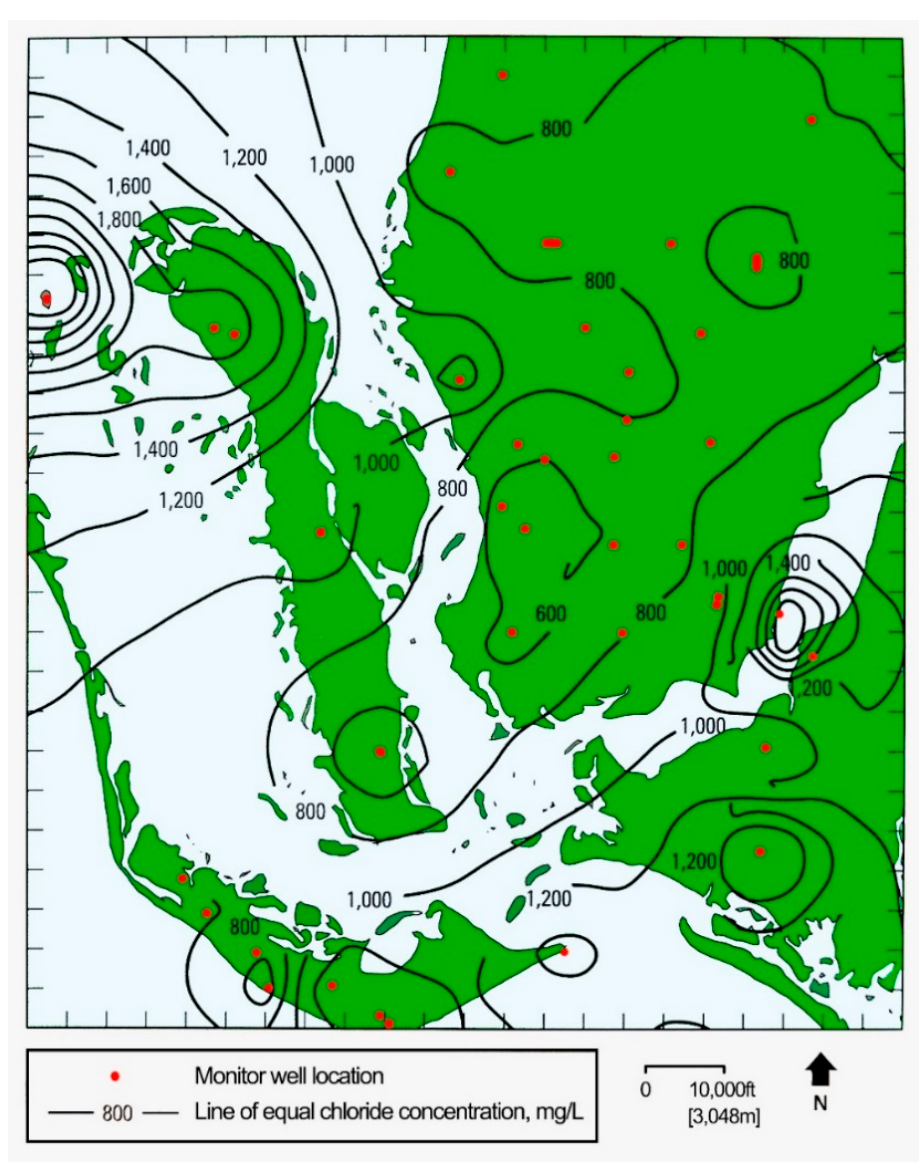
Figure 7. Dissolved chloride concentrations in the Lower Hawthorn Aquifer in the City of Cape Coral. Note the very high dissolved chloride concentration in the lower eastern part of the map, which is near the Caloosahatchee River bridge (from [12,21]).